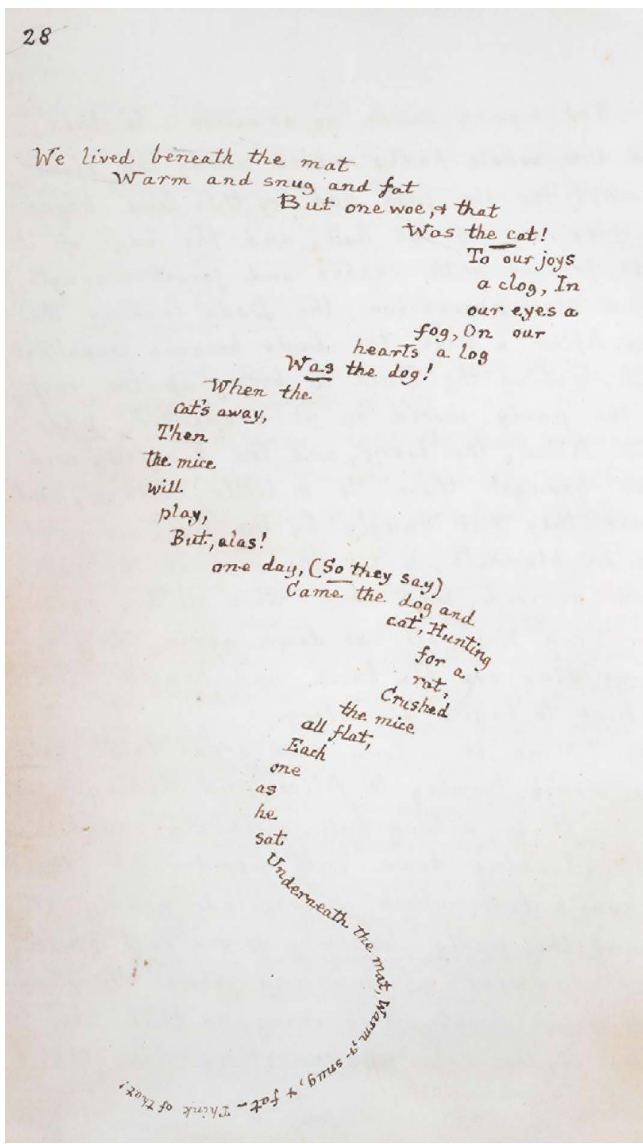
text, and thus play a secondary role. However, it is now agreed that visual narratives take on meanings of their own, although always read in relation to the written text (Kress, 1997; Kress & van Leeuwen, 2006) through synergistic relationships (Sipe,